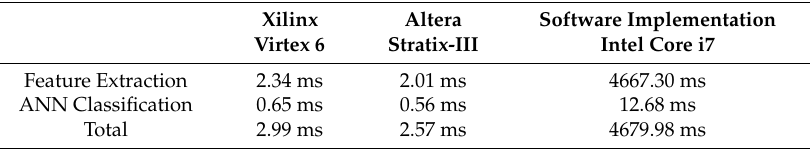
Table 3. Implementation response time for each implementation case.